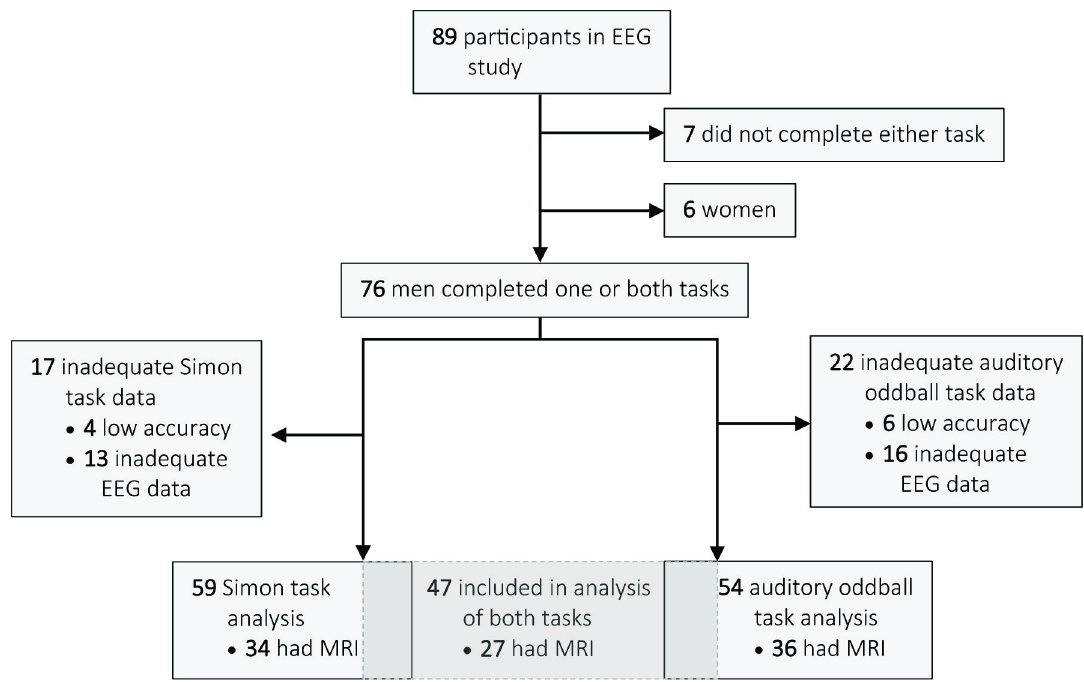
Fig 1. CONSORT diagram of the study. Participants who performed the task at chance accuracy or who had fewer than 25 usable EEG trials after pre-processing were excluded. Data were only available for 6 women, insufficient to reliably adjust for sex effects, so the analysis was restricted to men. Sixty-six men had complete data for at least one task, 47/66 had complete data for both tasks. Structural MRI was available in 43/66. Cognitive performance data were available for all participants.